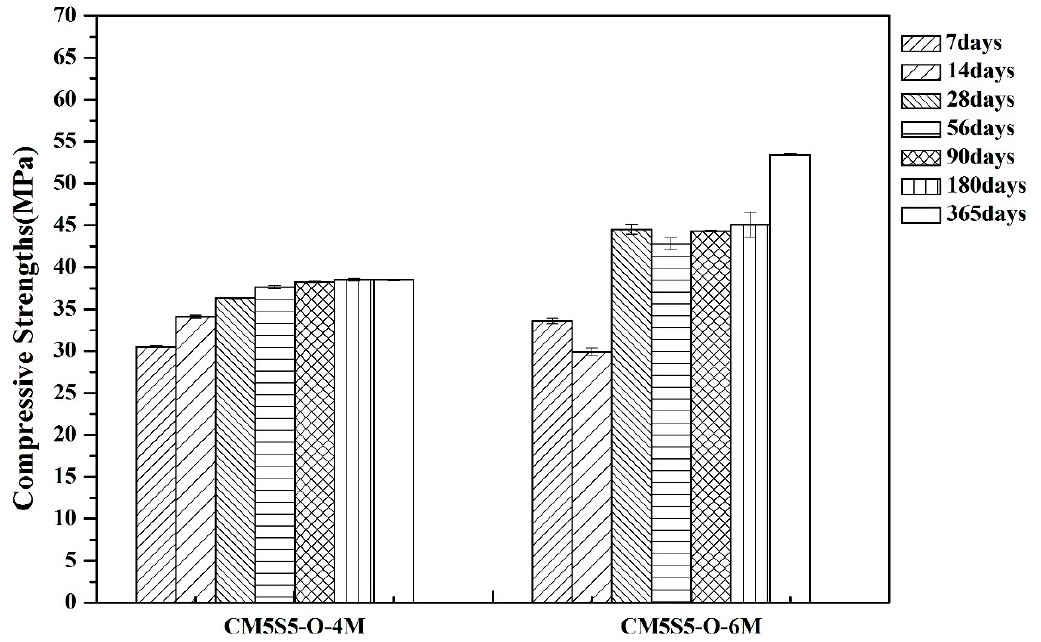
Figure 6. E ff ect of the NaOH molar concentration on the compressive strength of marble-based geopolymer concrete.